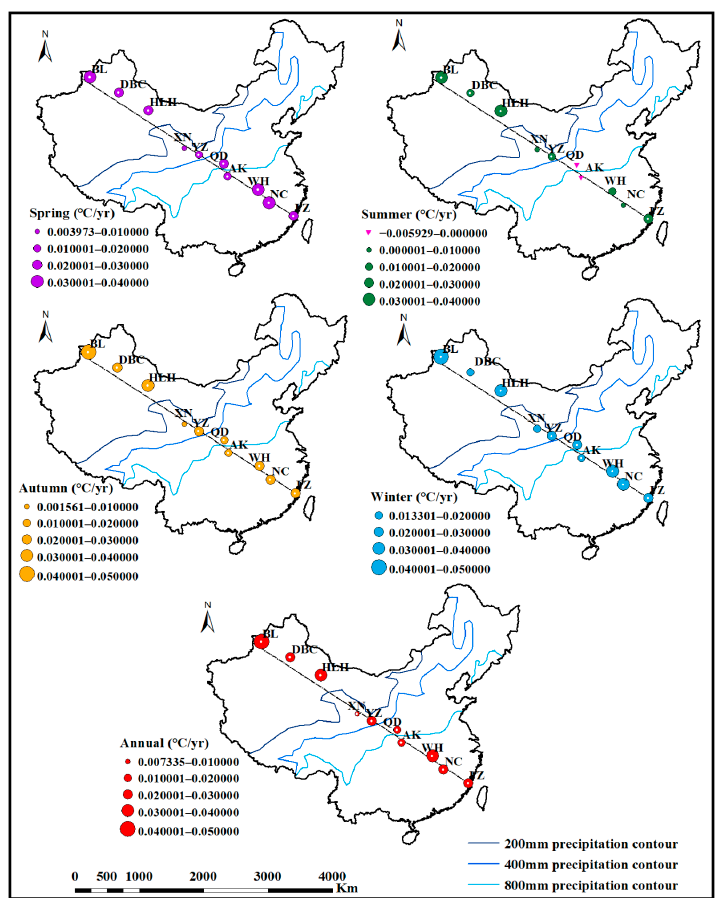
Figure 13. The Sen’s slope of Mann-Kendall trend test was used to reflect the variation trends for the average daily temperature from 1961 to 2017. Note: white spots mean precipitation change trend reached the significance level of 95% confidence for the MK trend test.